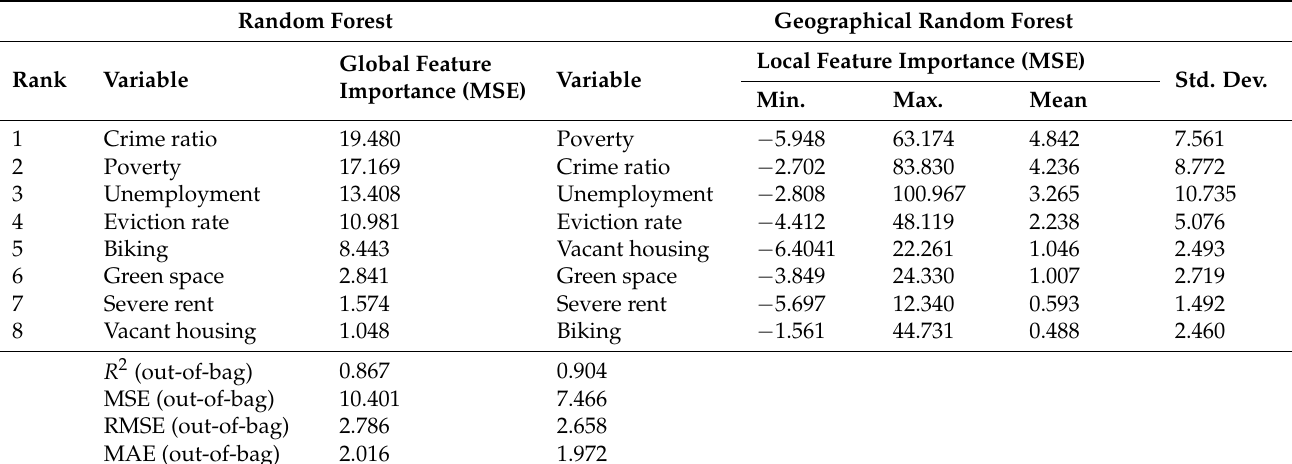
Table 2. Results of random forest and geographically random